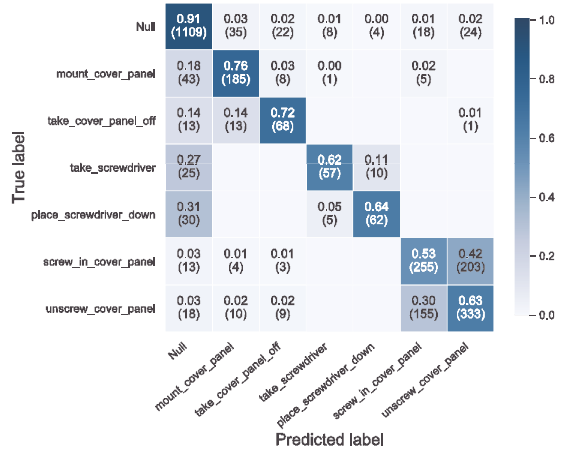
Fig. 4. Confusion matrix of CNN-2 on the OCA dataset.